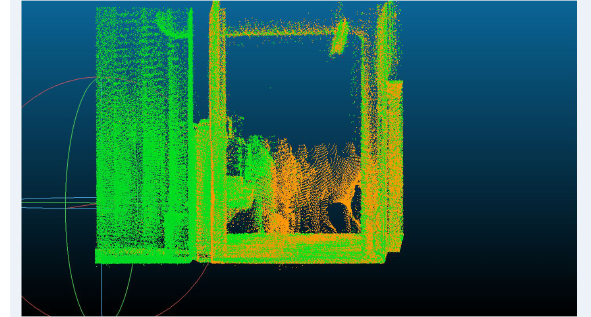
Figure 9. Multiple scanning times: orange is scan time one and green is scan time